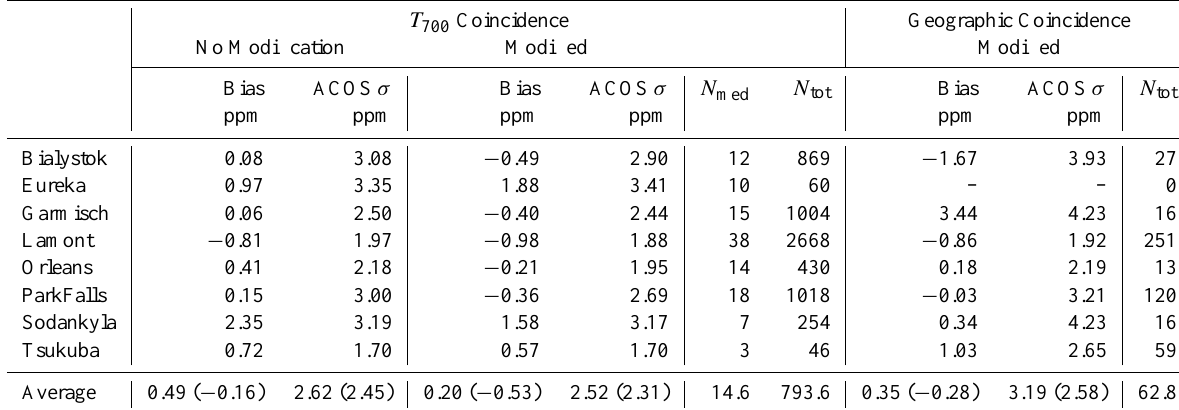
Table B3. This table presents the results of three comparisons between Northern Hemisphere TCCON X CO for the v2.9 ACOS-GOSAT data. Coincidence between the two datasets are determined either by the T 700 constraint (ACOS-GOSAT soundings within ± 2K, ± 10° latitude by ± 30° longitude and 10 days of a TCCON measurement), or a geographic constraint ( ± 0 . 5° latitude by ± 1 . 5° longitude). Biases are computed by subtracting the TCCON X CO have not had the v2.9 regression applied. The “Modified” fields have had the v2.9 regression applied. The “ACOS σ ” field lists the mean standard deviation of the ACOS-GOSAT data for a particular location. The column labeled “ N med ” is the median number of ACOS-GOSAT spectra involved in a single coincidence for a particular site. The columns labeled “ N tot ” are the total numbers of ACOS-GOSAT spectra involved with the comparison for all times at that site. The averages in parentheses are weighted by N tot . There are no ACOS-GOSAT data coincident with the Eureka site using the geographic constraint.